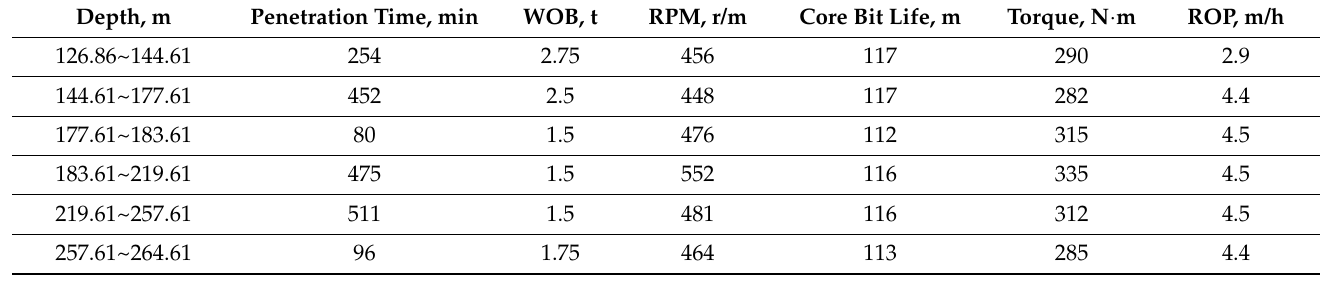
Table 4. Statistics on bit-drilling efficiency of diamond core bit in Pingdu Hole 28ZK5.